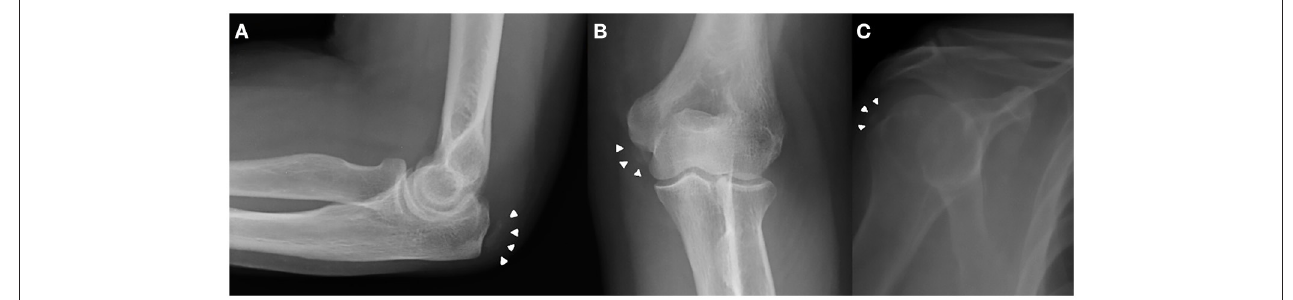
FIGURE 2 | Previous elbow and shoulder X-ray obtained for minor traumatic events revealed the presence of CPPD crystal deposition (white arrowheads) at the level of writs flexors insertion at medial epicondyle (A,B) and rotator cuff (C) as well.